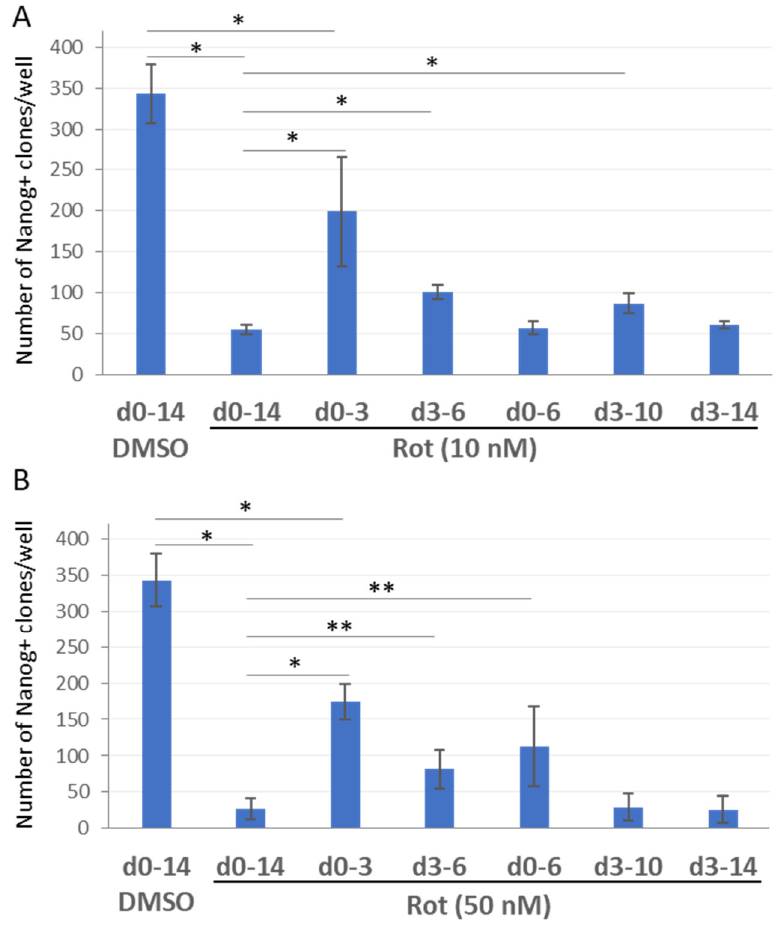
Figure 3. ETC CI suppression by rotenone shows stage-specific effects on reprogramming outcomes. ( A ) Rotenone treatment at specified concentrations during the first 3 days of reprogramming exerts a significantly lesser effect on iPSC clone number than the treatment during the first 6 or 10 days, or during 3–10 or 3–14 days of the reprogramming process. ( B ) Rotenone treatment (50 nM) during the first 3 and 6 days causes a significant increase in cellular reprogramming, when compared with its treatment during the first 10 days, or during 3–10 or 3–14 days of the reprogramming process. In both charts, the y -axis represents the mean number of the Nanog-positive clones by day 14 of reprogramming ± SD, n = 3, * p < 0.001, ** p < 0.01. The x -axis indicates the time intervals (in days) of rotenone treatment during reprogramming process.